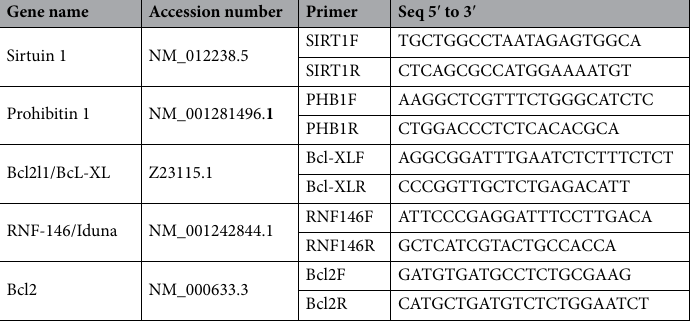
Table 1. Primer sequences used to measure mRNA content in human primary lung culture by SYBR green Real-Time Polymerase Chain